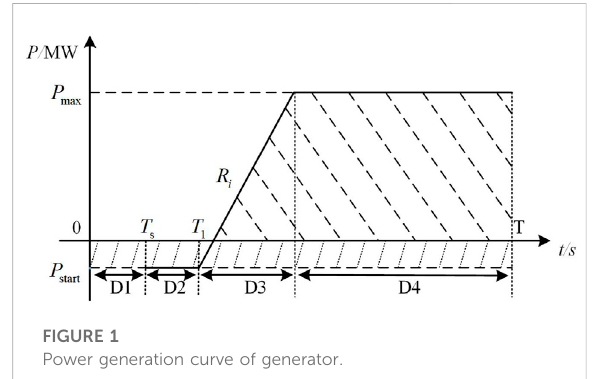
FIGURE 1 Power generation curve of